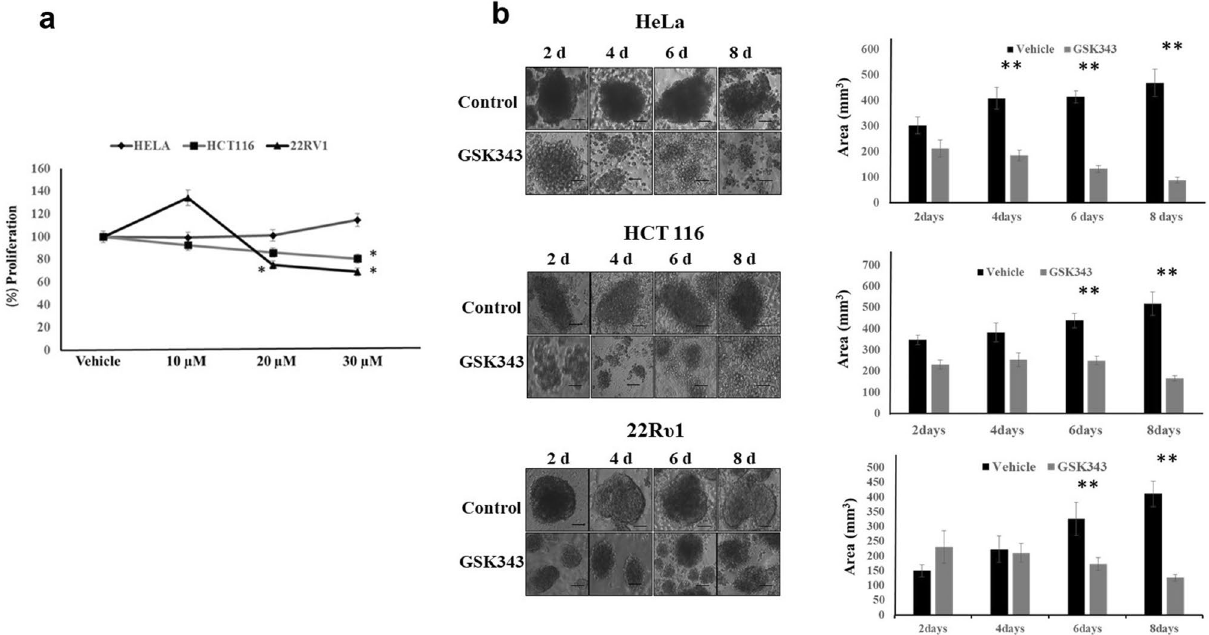
Figure 2. EZH2 methyltransferase activity inhibition by GSK343 reduces cell viability and sphere-forming capability. ( a ) Different cancer cell lines, namely 22Rυ1, HCT116, and HeLa, were treated with GSK343 and EZH2 specific inhibitor, and cell viability assay was performed at 48 h; *P < 0.05. ( b ) Cancer cells HeLa, HCT116, and 22Rυ1 were grown in low attachment plates, and E.C.M. detached cells (spheres) were treated with different concentrations of GSK343 for 2–8 days, and images were captured by Nikon inverted light microscope at ×40. Images were analyzed for size measurement using image J software (mean ± S.E.M., n = 8). * P < 0.05. A total number of 100 spheroids were quantified for size analysis.